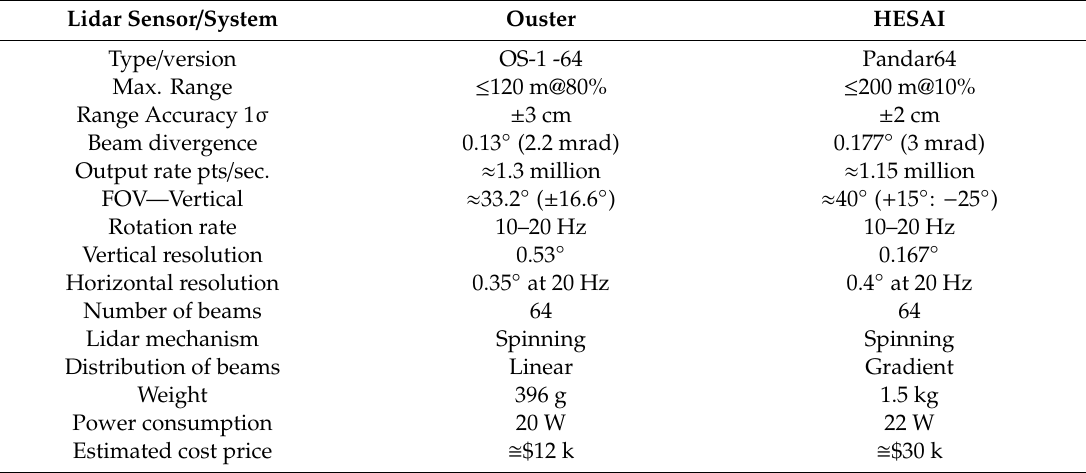
Table 1. Specifications of the investigated Lidar types.